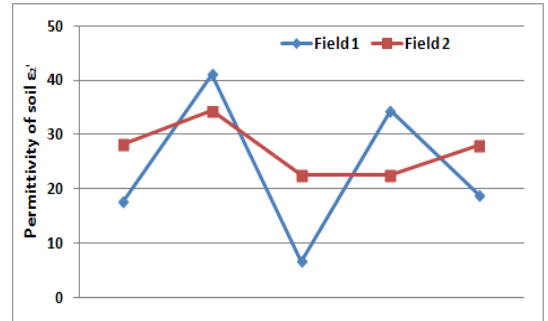
Fig.3 Permittivity of soil retrieved after application of genetic algorithm for the collected samples in two fields of sugarcane (5 samples were collected in each field).